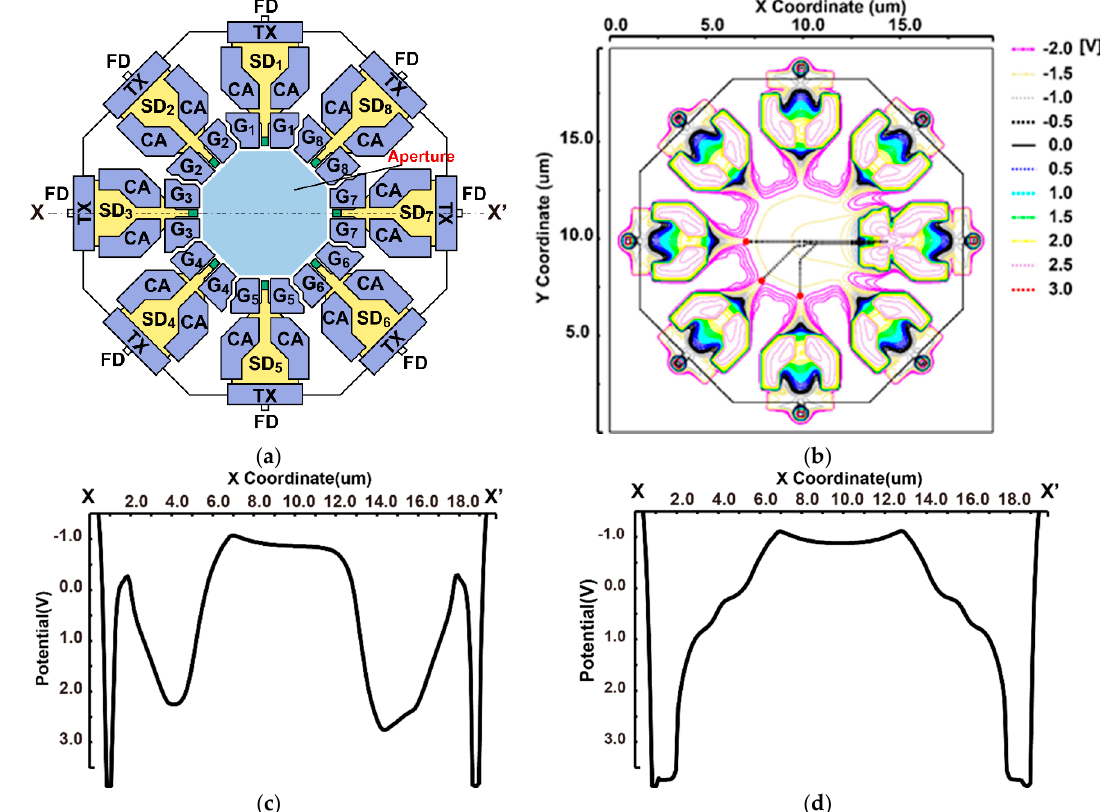
Figure 5. 3D device simulation results: ( a ) structure of the 8-tap lock-in pixel, ( b ) charge transportation result, ( c ) potential diagram of the storage diode (SD) accumulation mode (X–X’), and ( d ) potential diagram for the charge transfer mode from the SD to floating diffusion (FD) (X–X’).